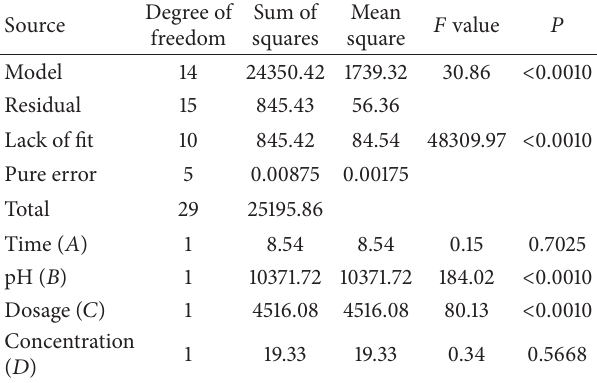
Table 3: ANOVA for removal of lead from aqueous solution using tartrate-Mg-Al layered double hydroxide.